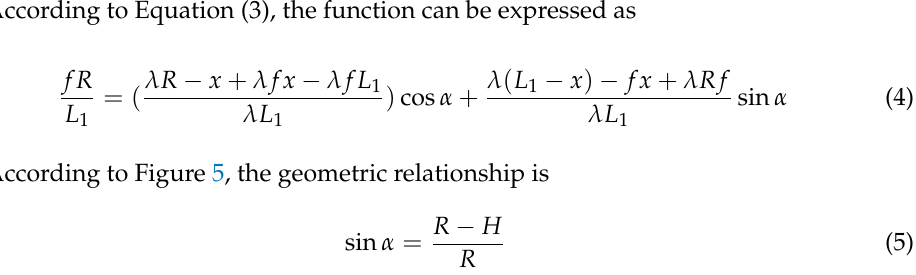
Figure 6. Robot’s front wheel’s contact with the step.